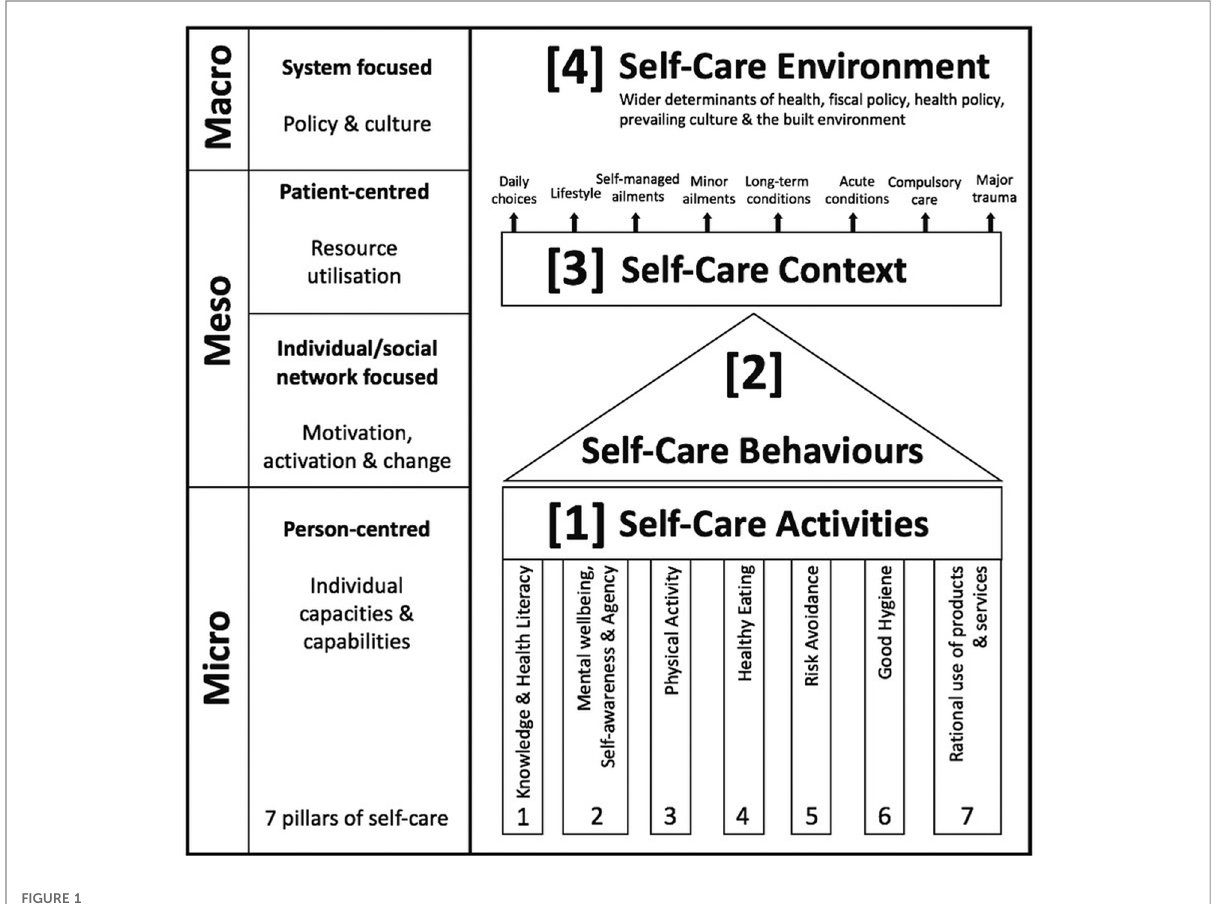
FIGURE 1 The self-care matrix